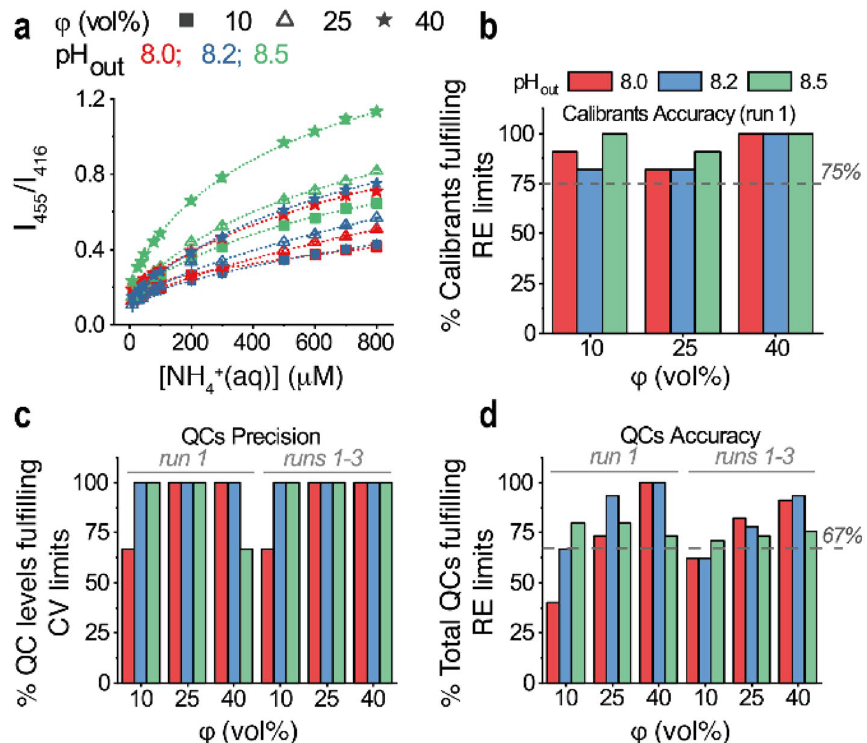
Figure 3. PoSo-HPTS calibration curves and assay performance for varying φ and pH out . ( a ) Ammonia sensing calibration curves obtained with sigmoidal regression fit of the measured fluorescence intensity ratio I 455 /I 416 (λ em = 515 nm) data plotted over [NH 4 + (aq) ] in the calibrant solutions. Assay was performed at various φ and pH out values using PoSo-HPTS. Eleven calibration levels within 30–800 µM NH 4 + (aq) in PBS were used, while a 10 μM standard served as anchor point. For each condition, results are presented as mean ± SD (n = 3) of replicate wells from one experimental run (run 1); error bars may be smaller than symbols. In total three independent runs were performed (runs 1, 2, and 3). Conditions: pH in 6.0, [HPTS] in = 1 mM, [HPTS] assay = 0.4 µM. ( b ) Fraction of calibration levels from ( a ) with mean back-calculated [NH 4 + (aq) ] having RE within ± 15% (or ± 20% for LLOQ). Dotted line indicates the minimum acceptable fraction according to EMA 24 and FDA 23 . ( c ) Fraction of independently prepared QC replicates (n = 5) per level (45, 400, and 750 μM NH 4 + (aq) in PBS; corresponding to φ = 10, 25, and 40 vol%, respectively) with assay-determined [NH 4 + (aq) ] having CV within ± 15% (or ± 20% for the lowest QC). ( d ) Fraction of total QCs (3 levels, n = 5 independent replicates per level) with assay-determined [NH 4 + (aq) ] having RE within ± 15% (or ± 20% for the lowest QC). Dotted line in ( d ) indicates the minimum acceptable fraction in accordance with EMA 24 and FDA 23